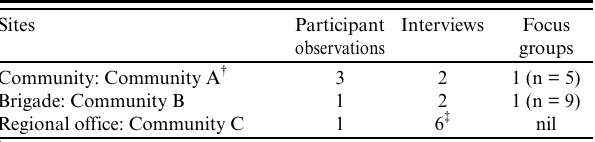
Table 1 . Research activities documented as part of the co-inquiry across three